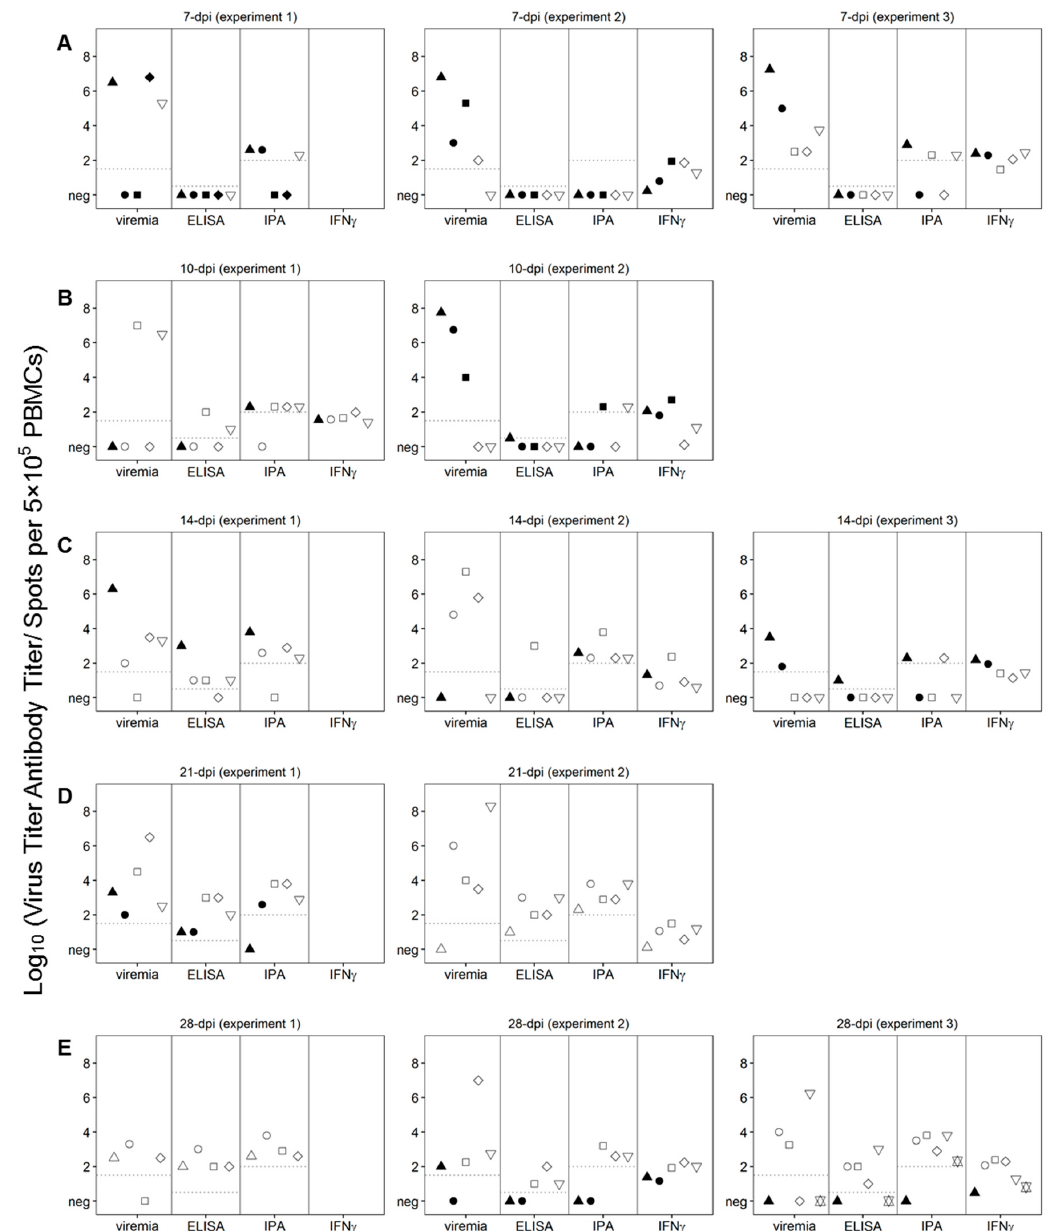
Figure 5. Viremia and immunological parameters at the time of challenge, day zero, in animals infected with Pret4 ∆ 9GL. Values of viremia, anti-African swine fever virus (ASFV) antibody titers detected by ELISA and immunoperoxidase (IPA), and the number of circulating ASFV-specific interferon (IFN)- γ -producing cells are presented for each individual pig. Survival status of swine is indicated as survived (white open shapes) or did not survive (black filled shapes). Pret4 ∆ 9GL virus infected-animals were challenged at 7 ( A ), 10 ( B ), 14 ( C ), 21 ( D ), or 28 ( E ) days later. PBMCs: peripheral blood mononuclear